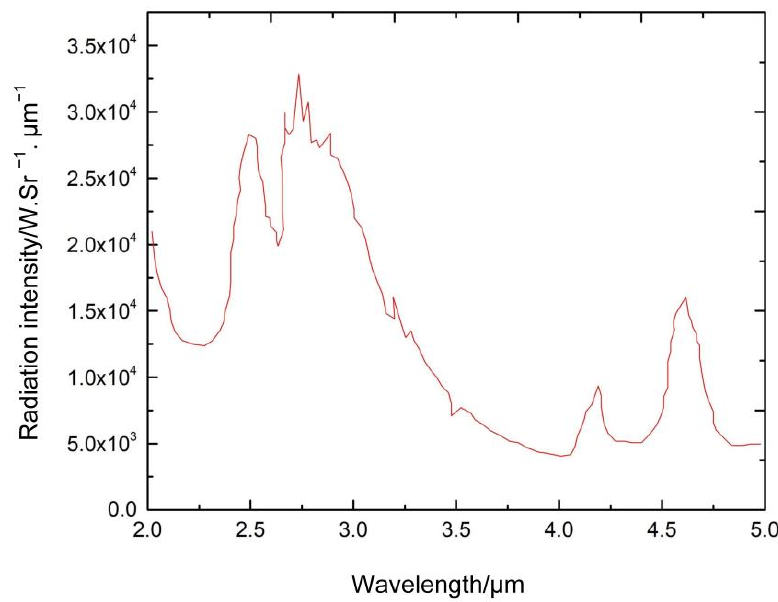
Figure 1. Spectral radiant intensity of a plume.